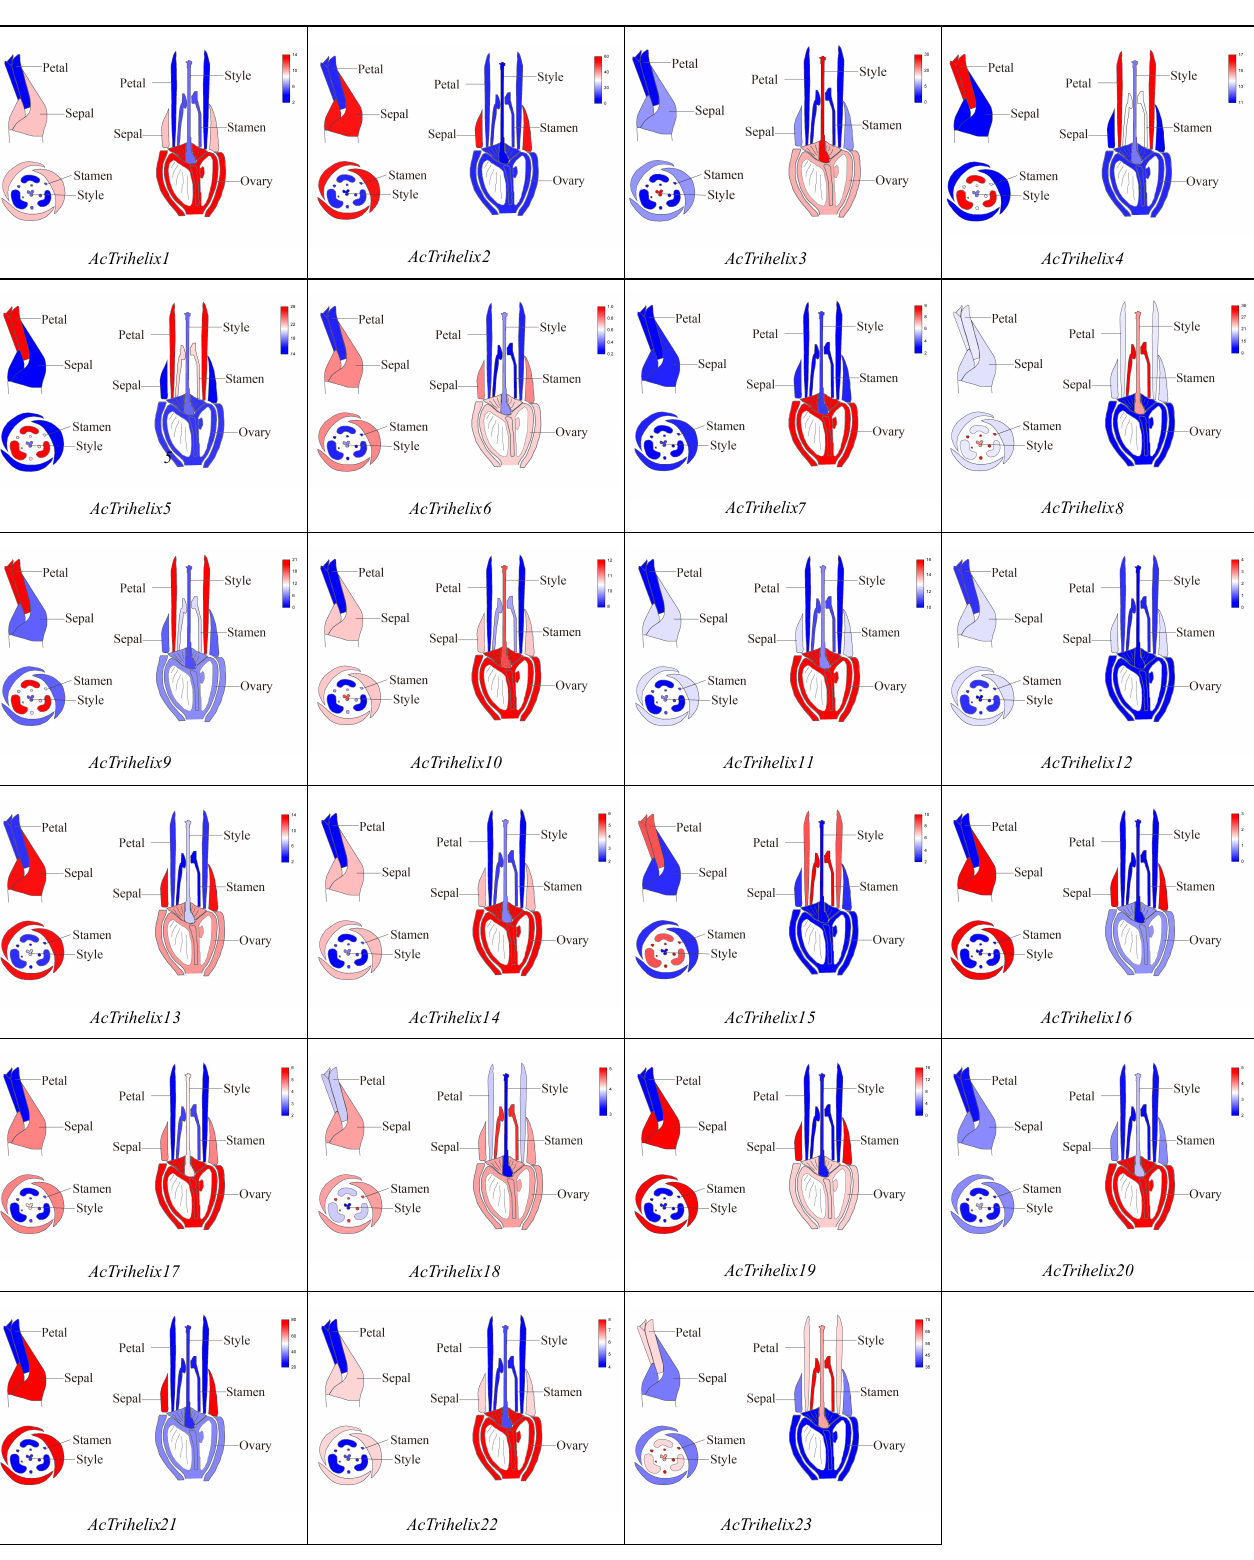
Figure 8. The expression of AcTrihelix genes in different floral organs. The red module represents high expression of tissues, and the blue module shows low expression. The patterns of expression were visualized with